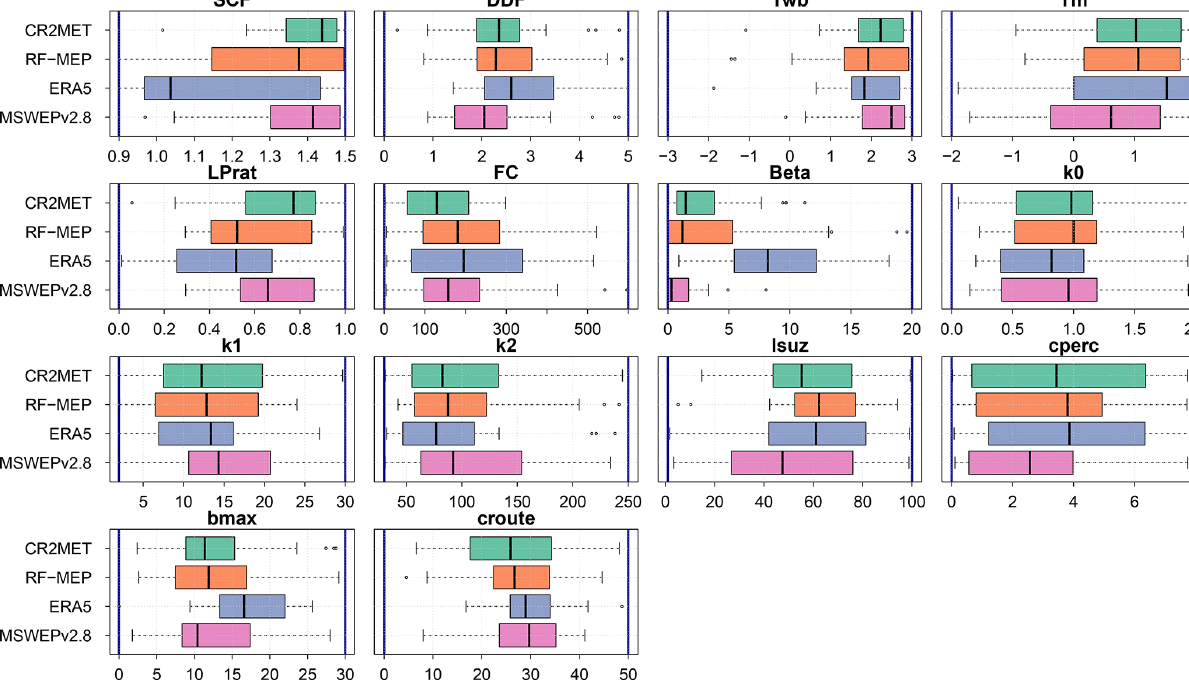
Figure 12. Model parameters obtained through calibration in nivo-pluvial catchments. The vertical blue lines indicate the upper and lower limits of the parameter